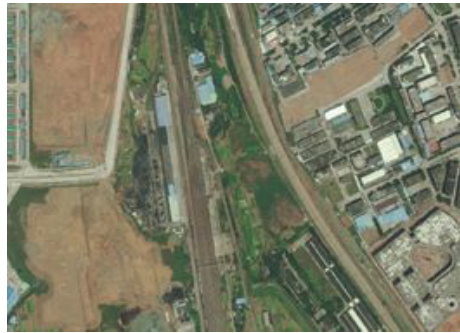
Figure 15. Experimental pleiades image